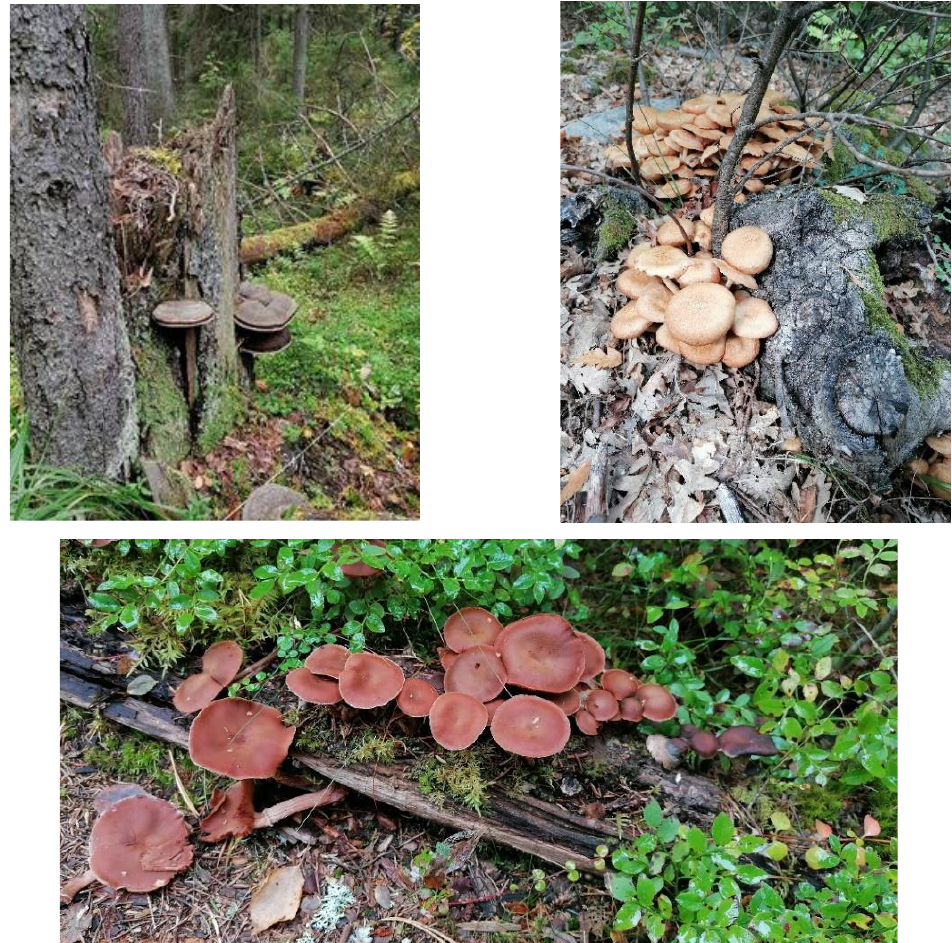
Figure 4. Deadwood as a substrate for the growth of Basidiomycete fungi. Hypoxylon frangiforme and Lopadostoma turgidum were found almost exclusively on deadwood at early stages of decomposition while Trechispora farinacea and Phanerochaete velutina were more frequently isolated from deadwood at late decay stages [58]. A key player in Norway spruce decomposition is Guehomyces pullulans , which is very efficient in conquering the habitat in the early stages of decomposition and, successively, as the decay progresses, providing its biomass to feed other species [42]. The white rot fungus Phlebia radiata proved to be an efficient early colonizer of deadwood, contributing to wood decomposition by the secretion of oxidative and carbohydrate-active enzymes [23]. In Norway spruce deadwood, these enzyme activities were associated with the